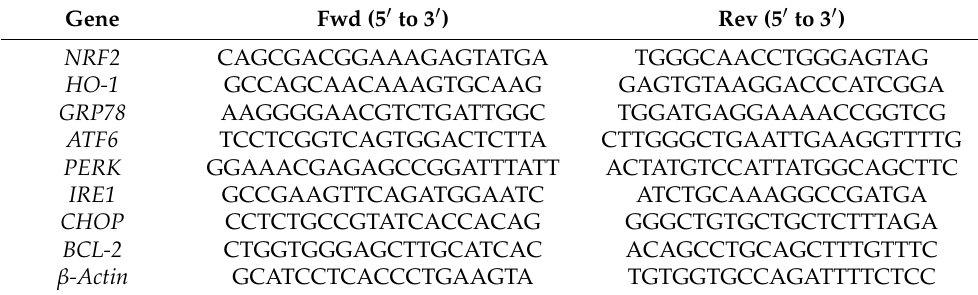
Table 1. Sequences of